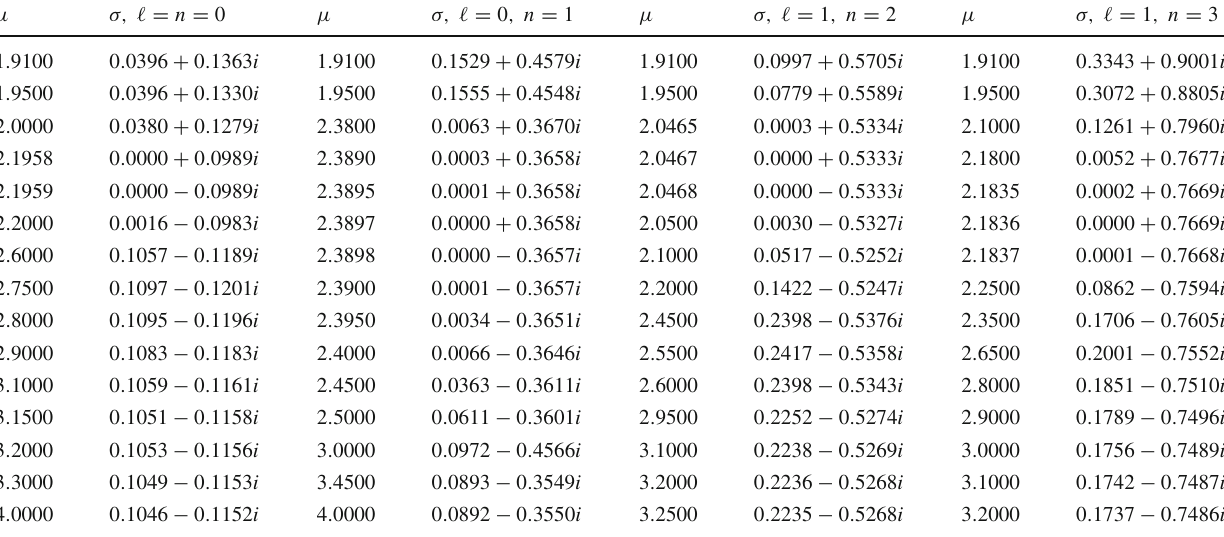
Table 2 Transition from unstable to stable modes in the cases (cid:3) = 0, n = 0 , 1, and (cid:3) = 1, n = 2 , 3, using the WKB approximation at the third